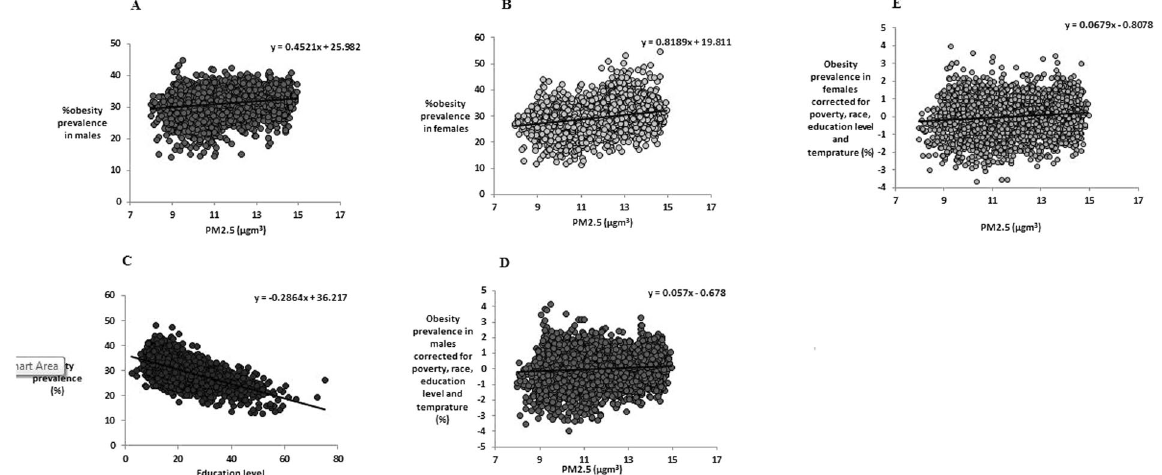
Figure 1. Association between levels of obesity prevalence for each sex and PM2.5 across the mainland USA. Plots show the county level data (n = 3106 counties) for ( A ) obesity prevalence and average PM2.5 ( µ g.m − 3 ) for males, ( B ) obesity prevalence and average PM2.5 ( µ g.m − 3 ) for females, ( C ) association between obesity prevalence and education level, ( D ) the association between obesity prevalence corrected for race, poverty, education and temperature and average PM2.5 ( µ g.m − 3 ) for males, ( E ) the association between obesity prevalence corrected for race, poverty, education and temperature and average PM2.5 ( µ g.m − 3 ) for